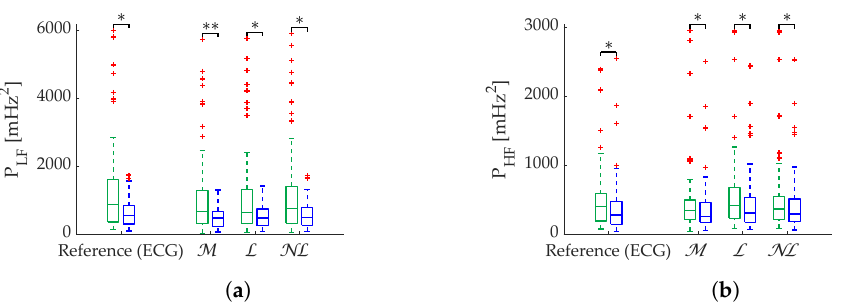
Figure 7. Relax (green)/Stress (blue) discrimination of frequency-domain metrics computed via FFT from Apple Watch dataset. ( a ) P LF . ( b ) P HF . *: Significant differences ( p < 0.05) between relax and stress groups. **: Significant differences ( p < 0.001) between relax and stress